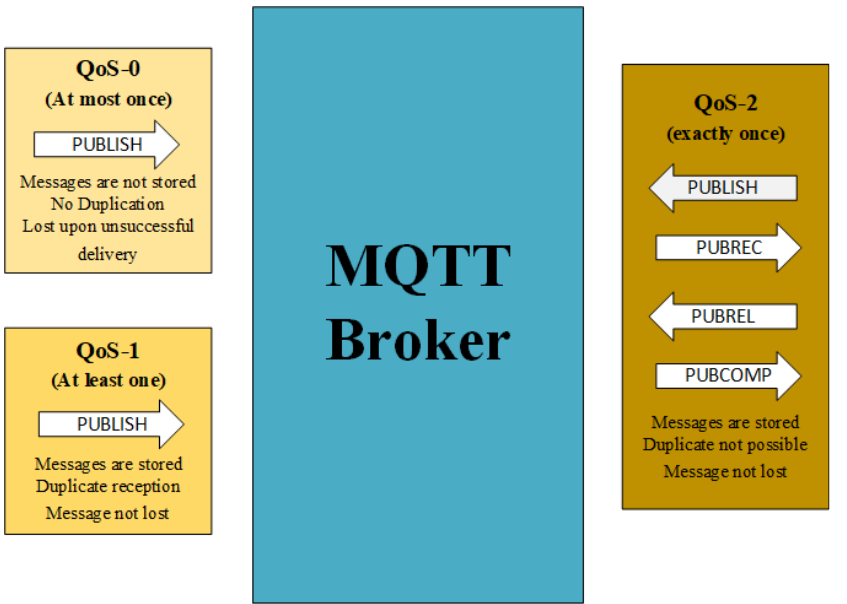
Figure 2. QoS-0-, QoS-1- and QoS-2-based MQTT broker with message delivery, duplication and storage status on the publishing node.